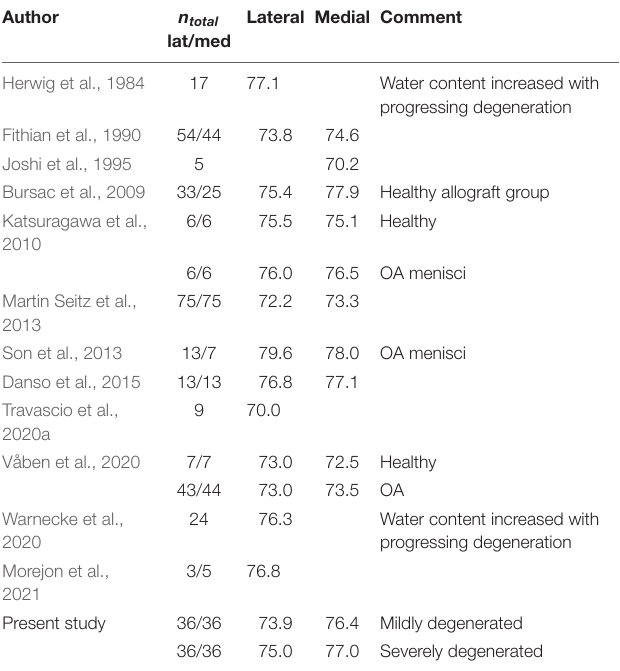
TABLE 5 | Mean water content values (in percent) of human knee joint